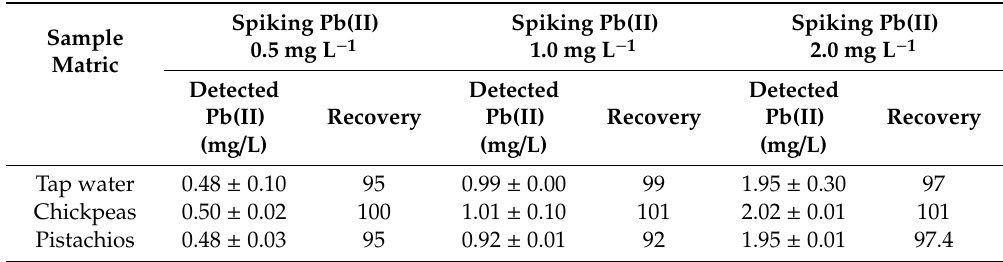
Table 4. Addition / recovery of Pb(II) from water and food samples using the developed deep eutectic microextraction.